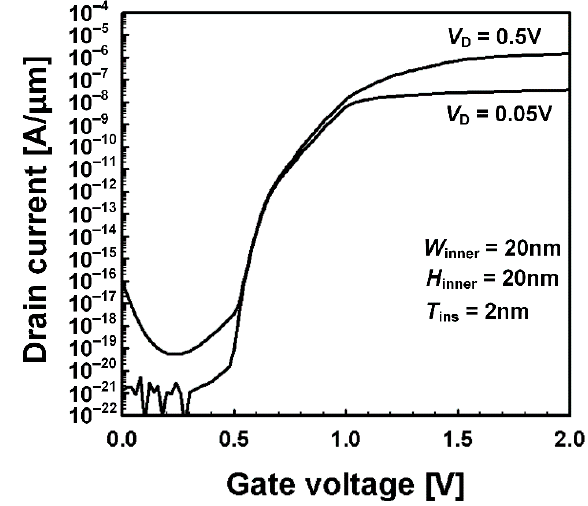
Figure 2. Transfer curves of the gate-normal NWTFETs for V D values of 0.5 V and 0.05 V. It is shown that gate-normal NWTFETs suffer from hump behavior, which degrades SS and I on .